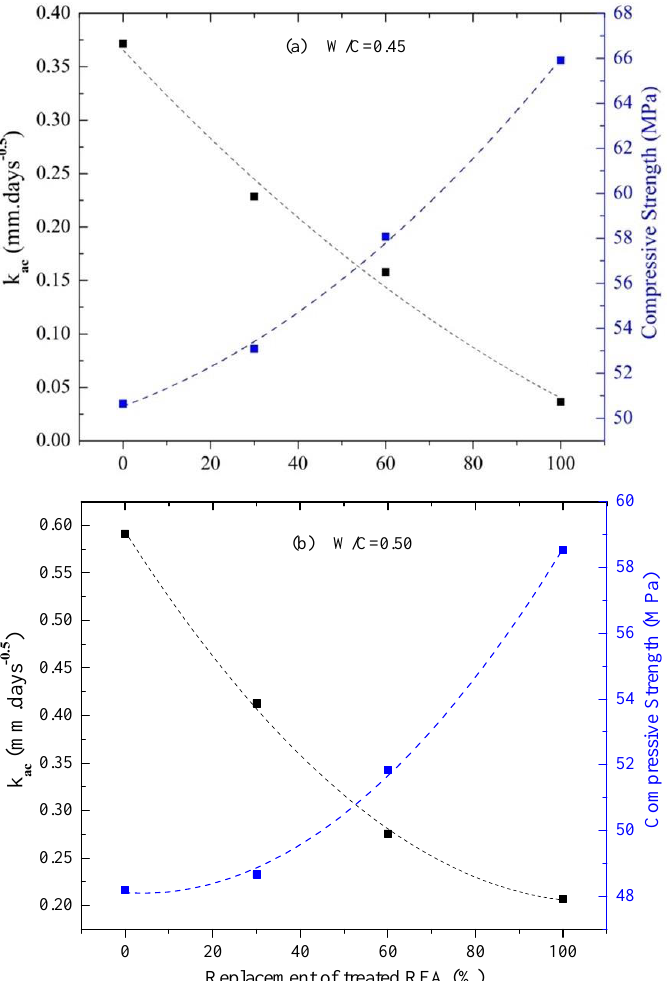
Figure 18. Correlation between k ac and the 28-day compressive strength for mortar with different replacement of treated RFA. (a) W/C: 0.45; (b) W/C: 0.50.